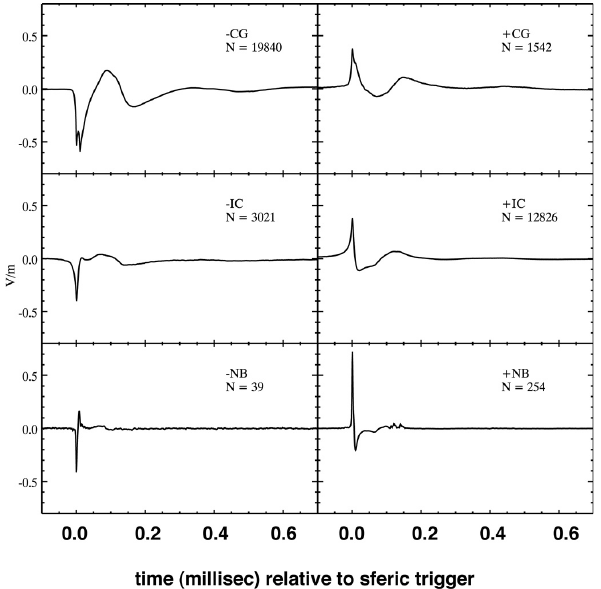
Fig. 14. Composite sferic waveforms, constructed as described in the